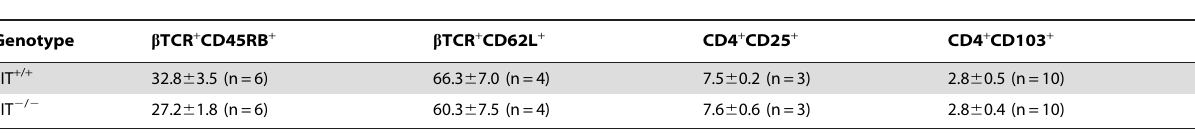
Table 1. T-cell subsets in lymph